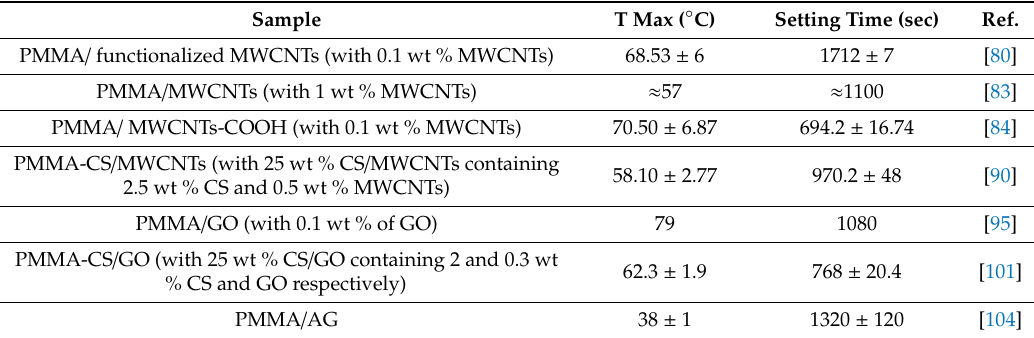
Table 2. Setting properties of the PMMA- based BCs containing MWCNTs, CS / MWCNTs, GO, CS / GO, and AG reinforcing